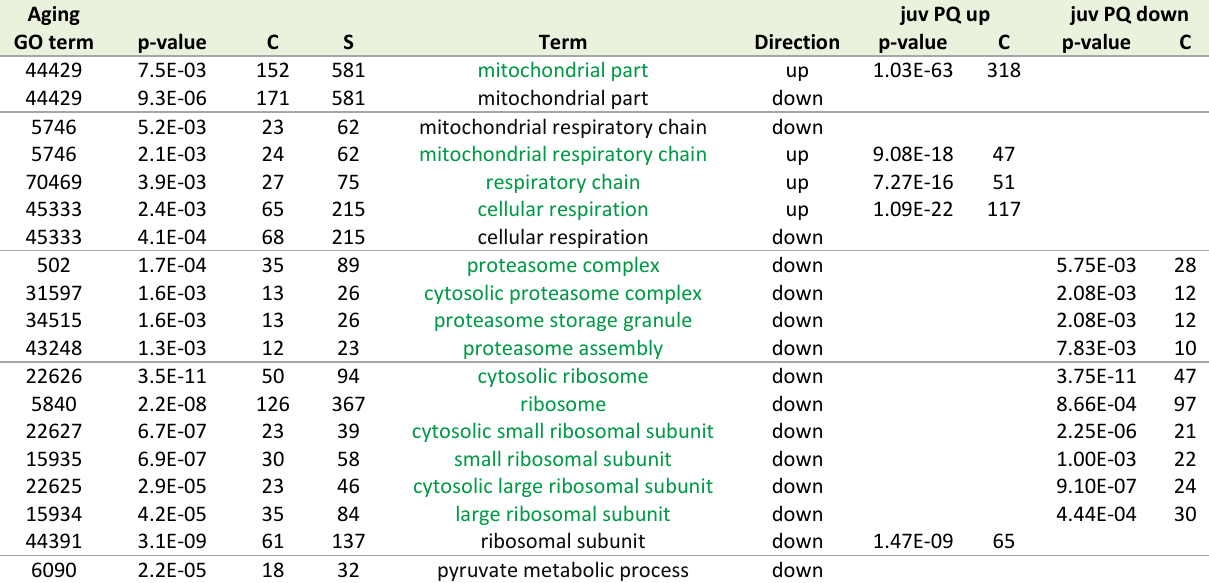
TABLE 3. Comparison of enriched GO terms in the data set of PQ-stressed P. anserina cultures with those from an earlier longitudinal aging study [19].